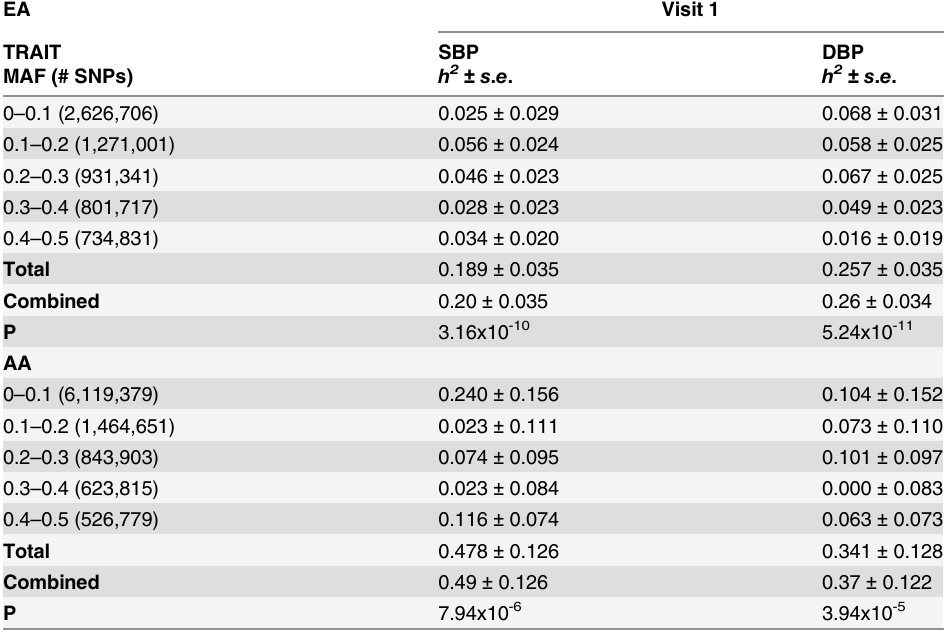
Table 3. Proportion of the genetic variance explained as a function of minor allele frequency (MAF) class using 8,901 EA and 2,860 AA individuals. The traits analyzed are first-visit SBP and DBP respec- tively for genotyped and imputed SNPs. The heritability (h 2 ), its standard error (se) and significance value (P) are